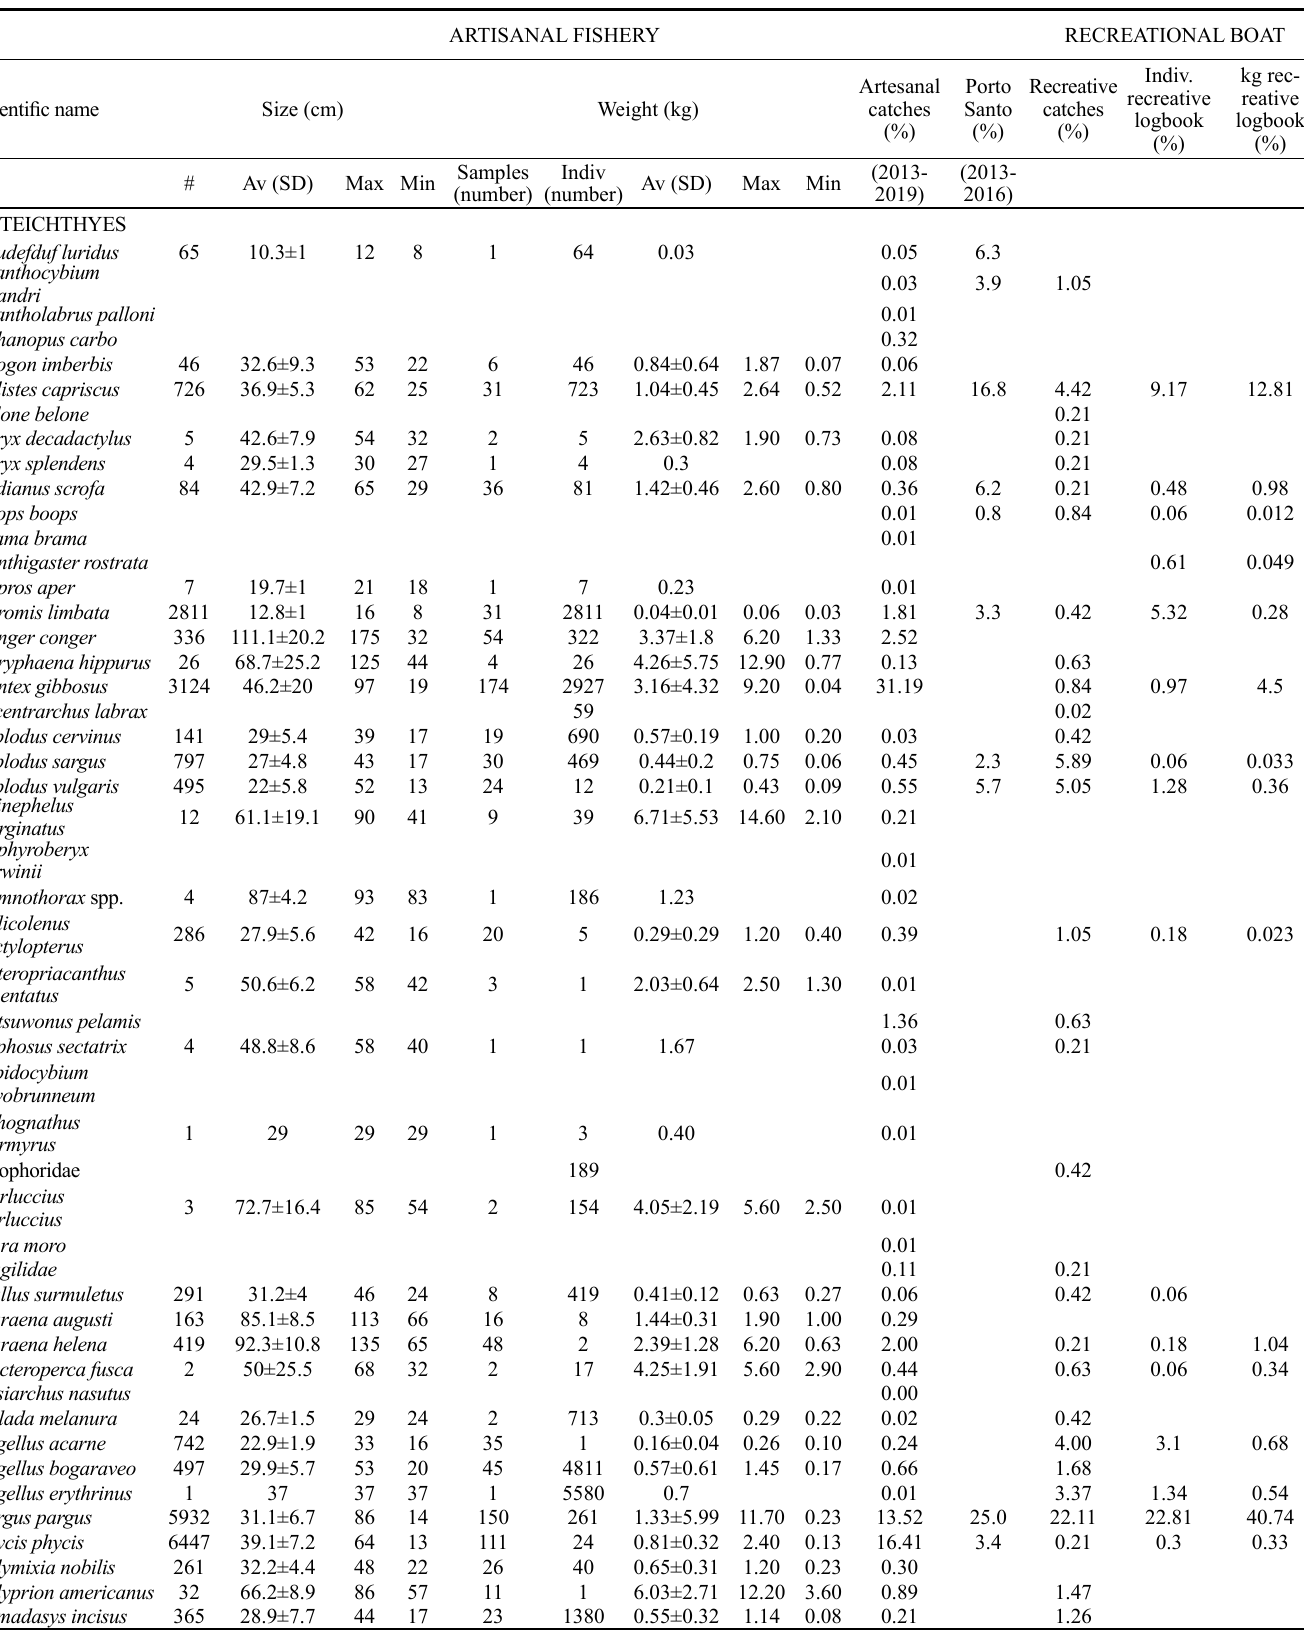
Table 3. – List of the species captured in the artisanal and recreational boat fishery (surveys and logbook), with the percentages (also for Porto Santo) of captures and average sizes and weights of species sampled in the artisanal fishery. Av, average; Sd, standard deviation; Min, minimum size; Max, maximum size; n, number of measured